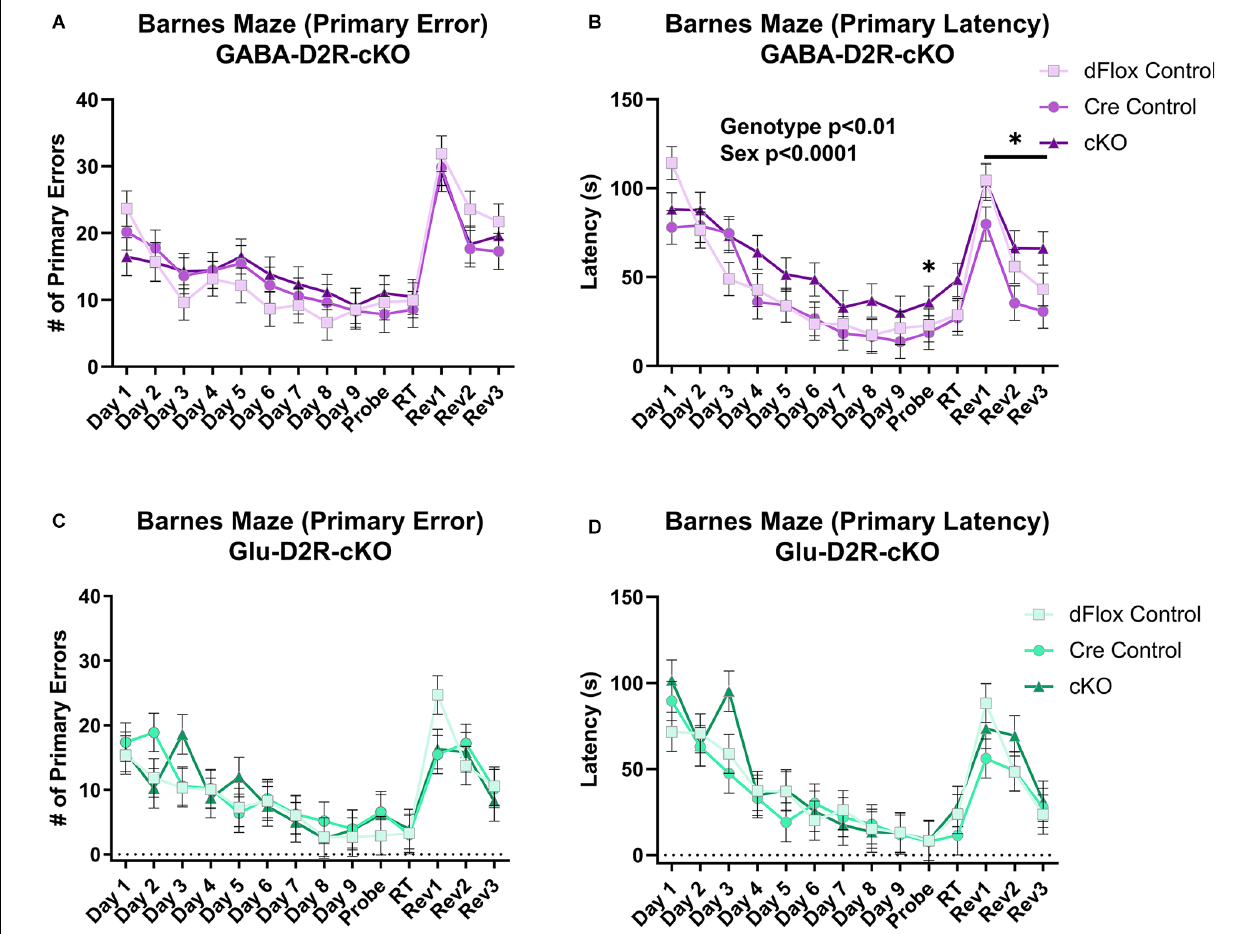
FIGURE 11 | Deficits in spatial learning memory in GABA-D2R-cKO mice. Only the GABA-D2R-cKO mice (A,B) showed a deficit in function compared to controls in primary latency (B,D) but not the primary error (A,C) . No such changes were observed in Glu-D2R-cKO mice (C,D) . N = 7–8/group for Glu-D2R-cKO mice and 18–19/ for GABA-D2R-cKO (several cohorts run to confirm the effects). ∗ p < 0.05 as compared to controls by post hoc